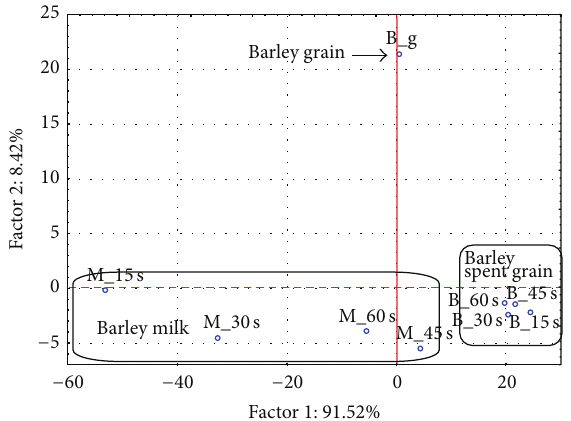
Figure 2: Principal component analysis of NIR absorbance spectra for barley grain (B g), barley milk (M), and spent barley grain (B) after 15, 30, 45, and 60 seconds of